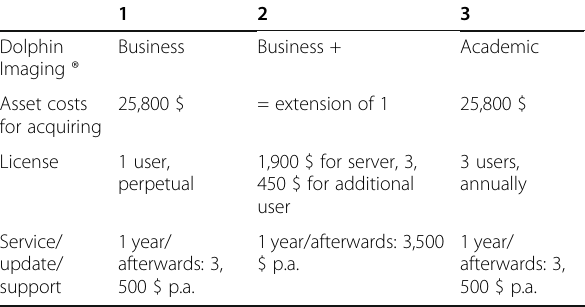
Table 2 Overview of the costs for the VSP system Dolphin Imaging ®